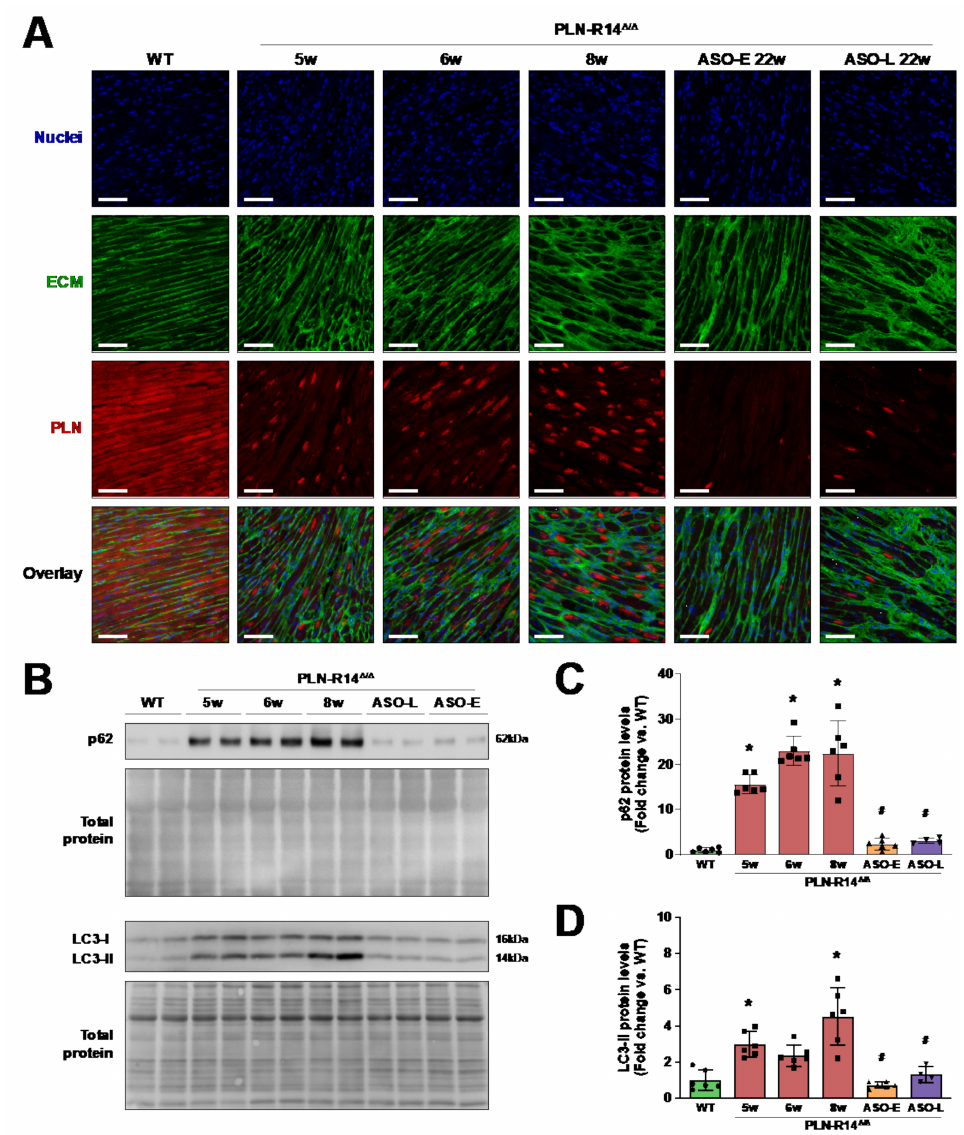
Figure 5. PLN protein aggregates were eliminated by PLN-ASO therapy. ( A ) Representative fluo- rescence images of WT mice and vehicle-treated or early or late ASO-treated PLN-R14 ∆ / ∆ mice at the age of 5, 6, 8 or 22 weeks stained for nuclei (DAPI) in blue (top), extracellular matrix (WGA) in green (second), PLN in red (third) and an overlay of all channels (bottom) (scale bar: 70 µ m). ( B ) Left-ventricular p62/sequestome 1 (SQSTM1), microtubule-associated protein 1A/1B-light chain 3 (LC3) and corresponding total protein levels in WT mice and vehicle-treated or early or late ASO- treated PLN-R14 ∆ / ∆ mice sacrificed at the age of 5, 6, 8 or 22 weeks. ( C , D ) p62 ( C ) and LC3-II ( D ) protein levels are normalized to total protein levels and quantified as fold change compared to WT mice ( n = 6 per group, except n = 4 for PLN-R14 ∆ / ∆ + ASO-late). Full blot images are shown in Figures S6 and S7. Data are shown as mean ± SD. * p < 0.05 vs. WT mice, # p < 0.05 vs. 8-week-old PLN-R14 ∆ / ∆ + vehicle (two-way ANOVA followed by Tukey’s post hoc